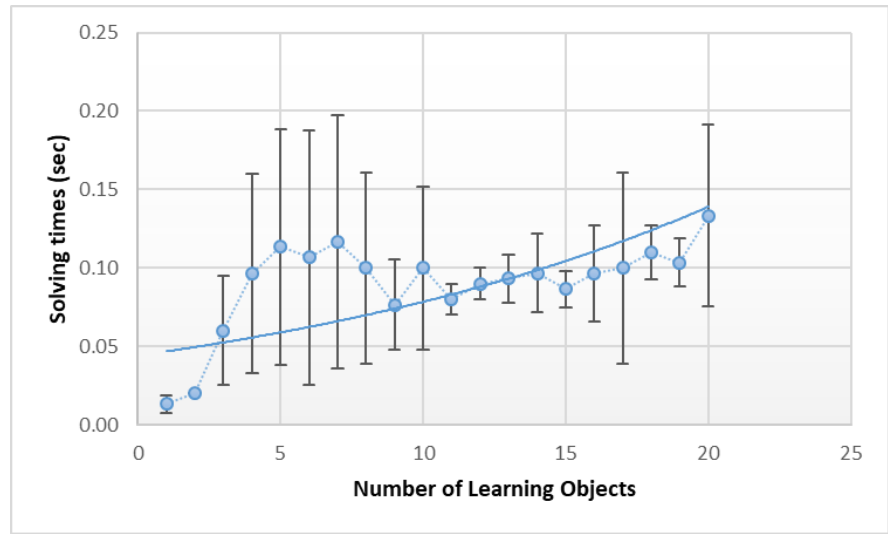
Figure 9. Resolution times, in seconds, compared to the number of learning objects present in the personalized